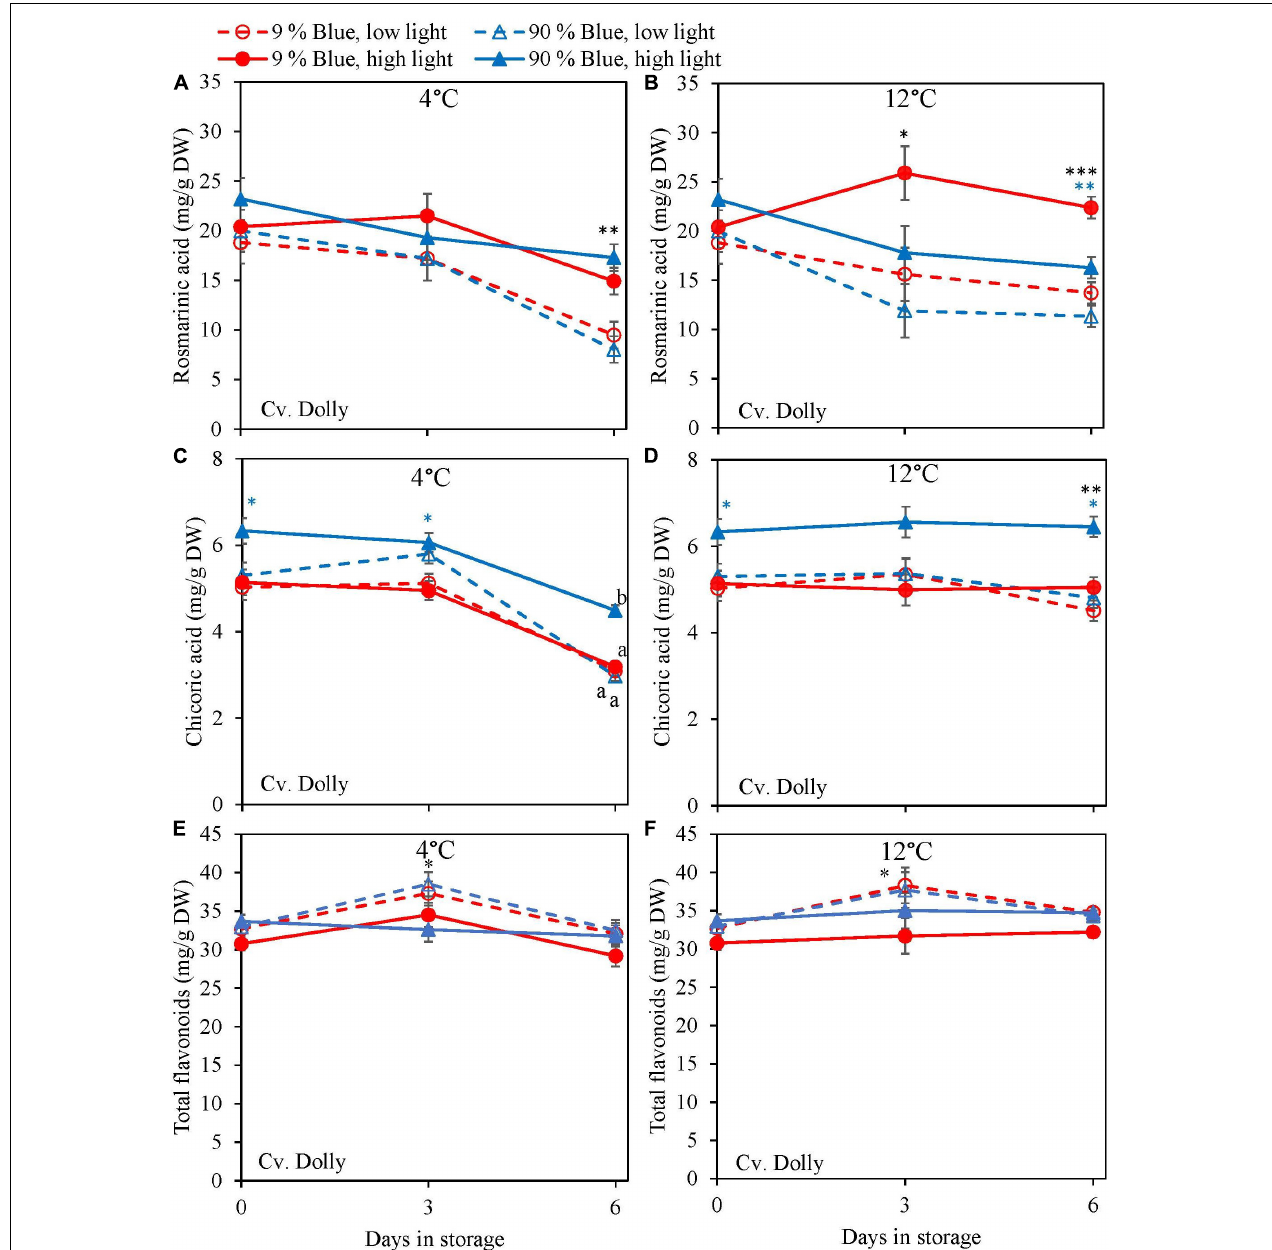
FIGURE 4 | Changes in metabolite levels during postharvest storage at 4 (A,C,E) and 12 ◦ C (B,D,F) in basil in the green cv. Dolly were exposed to EOP treatments. Plants were grown under red-white light (PPFD of 200 µ mol m − 2 s − 1 , 9% blue) for 30 days. The last 5 days before harvest plants were exposed to different EOP blue light ratios 9 or 90% at low PPFD (100 µ mol m − 2 s − 1 ) (open symbols) or high PPFD (300 µ mol m − 2 s − 1 ) (closed symbols). (A,B) Change in rosmarinic acid, (C,D) change in chicoric acid, (E,F) change in total flavonoid content. All values are expressed per gram dry weight in the leaves. The data are means of three blocks ( n = 3) (i.e., per block four replicate plants). Standard errors of means are shown as error bars. If no interaction was found but only the main effects were significant the indicated with p -values; ∗ p < 0.05, ∗∗ p < 0.01, ∗∗∗ p < 0.001 are depicted with either a blue (percentage of blue light) or black asterisk (PPFD). Letters indicate and interactive effect between the two main effects (percentage of blue light and PPFD), (Experiment 2).